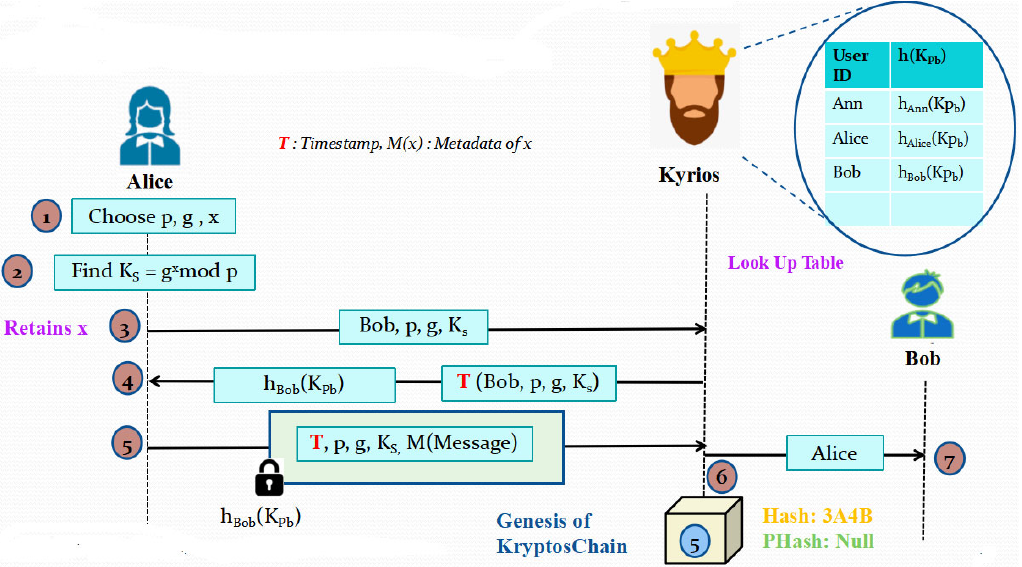
Figure 4. Illustration of Phase 3: Genesis Block Generation Process.